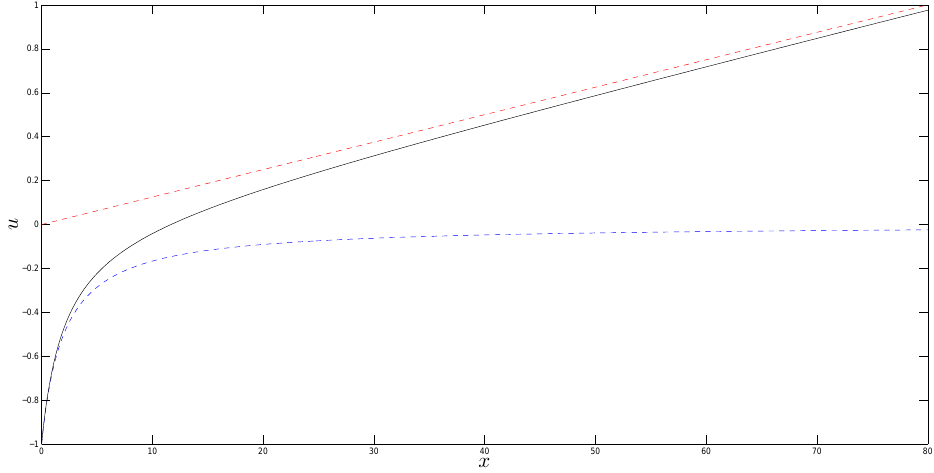
Figure 8: The numerical solution of QP in the ( x , u = v ) for x ∈ [0, 80] for u b = −1 and t = 40